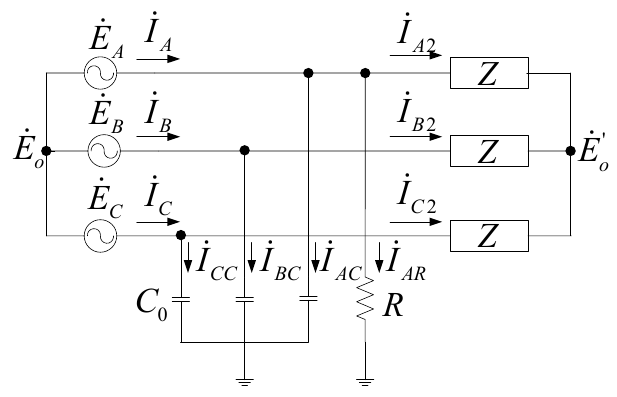
Figure 6. Equivalent circuit of single